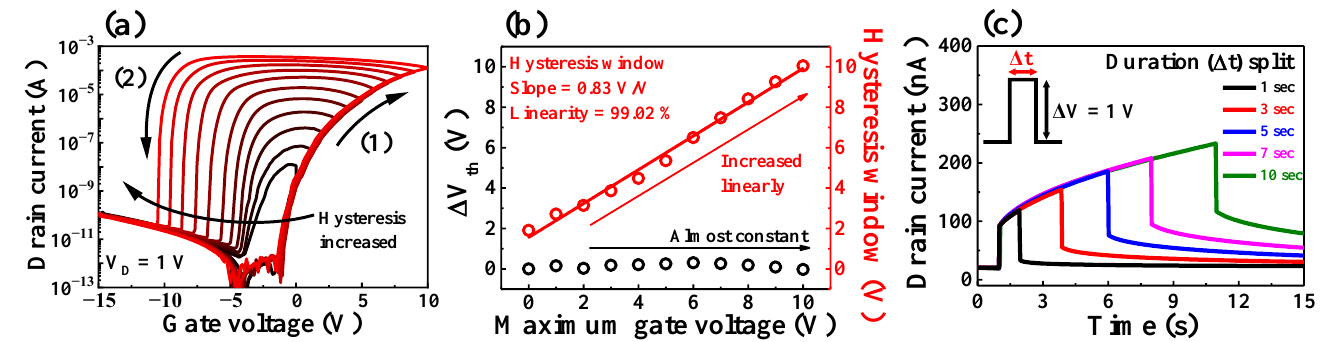
Figure 3. ( a ) Double-sweep transfer curves of the chitosan/Ta 2 O 5 hybrid dielectric EDLT at increasing maximum V G ; ( b ) threshold voltage and hysteresis window extracted from the transfer curves; ( c ) dynamic I D responses to gate pulses of various durations.